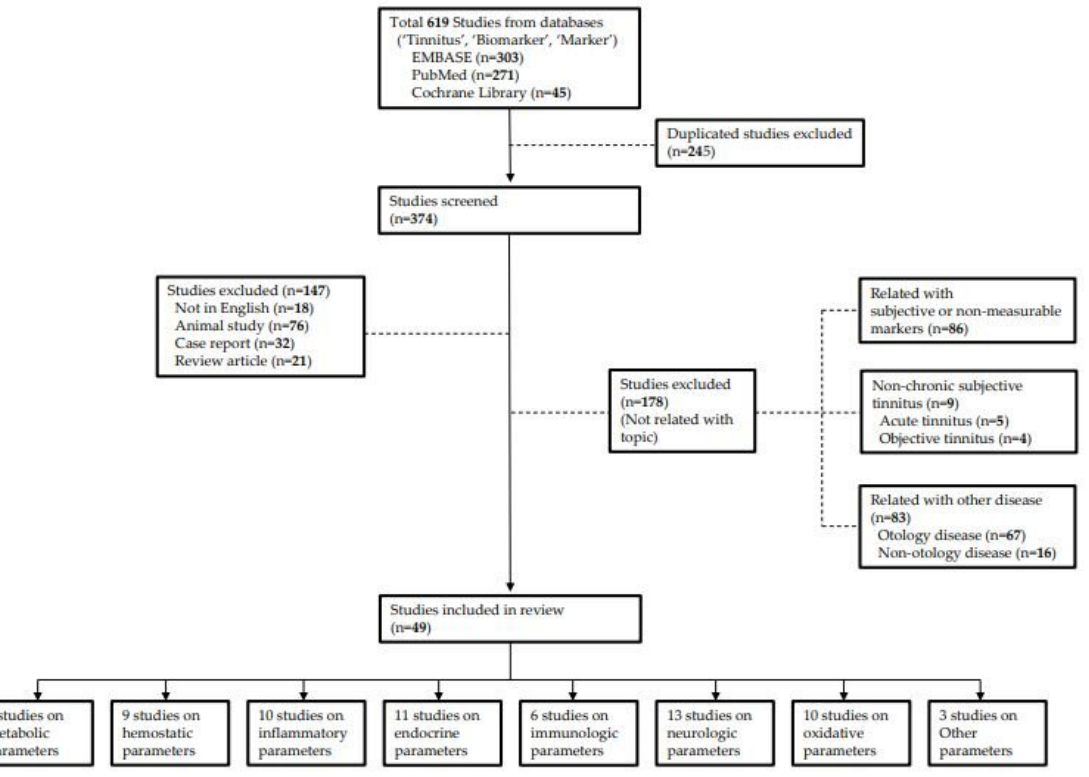
Figure 1. Flow diagram for review.